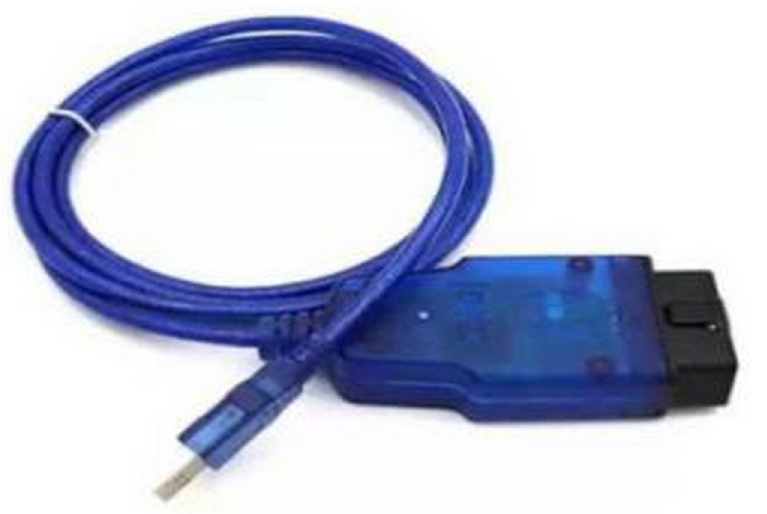
Fig 2. USBCAN-OBD